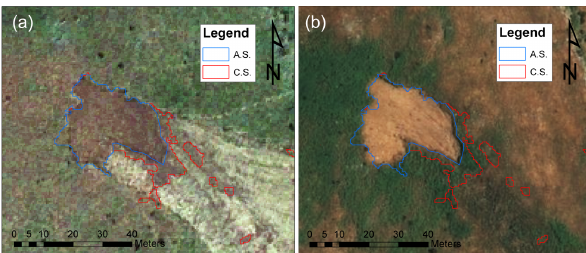
Fig. 4. Example of an edited polygon: in blue the edited contour (A.S.) and in red the contour extracted during the classification pro- cedure (C.S.). (a) GeoEye1 image and (b) the orthophotomap.